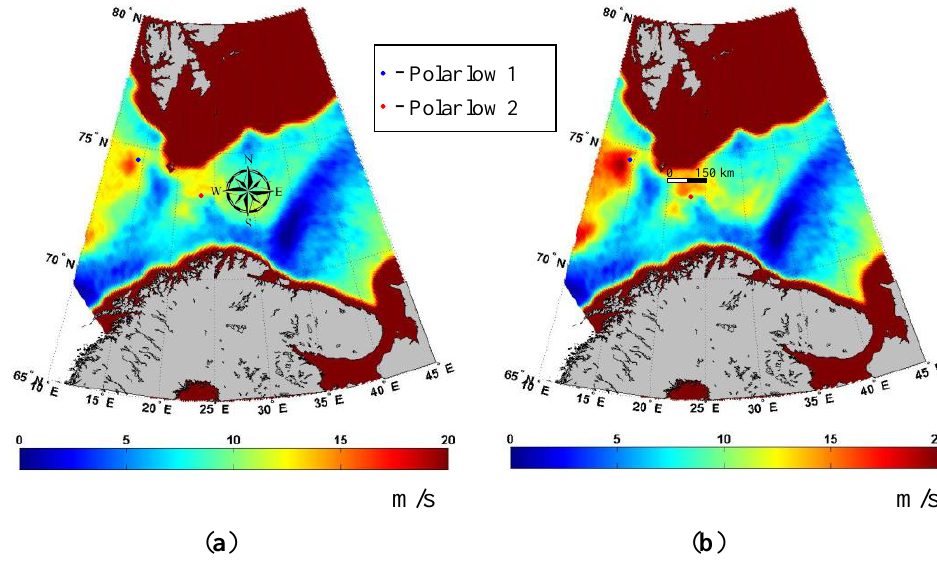
Figure 6. Polar lows 1 and 2 in the Barents Sea on 12 March 2011 at 9:56 UTC. Sea surface wind speed was derived from Aqua AMSR-E measurement data with Neural Network algorithms: ( a ) the algorithm is trained using brightness temperature calculations with an old geophysical model [21], ( b ) the new algorithm. The dark red areas indicate ice covered regions and coastal zone with strong land contamination where the retrievals are not